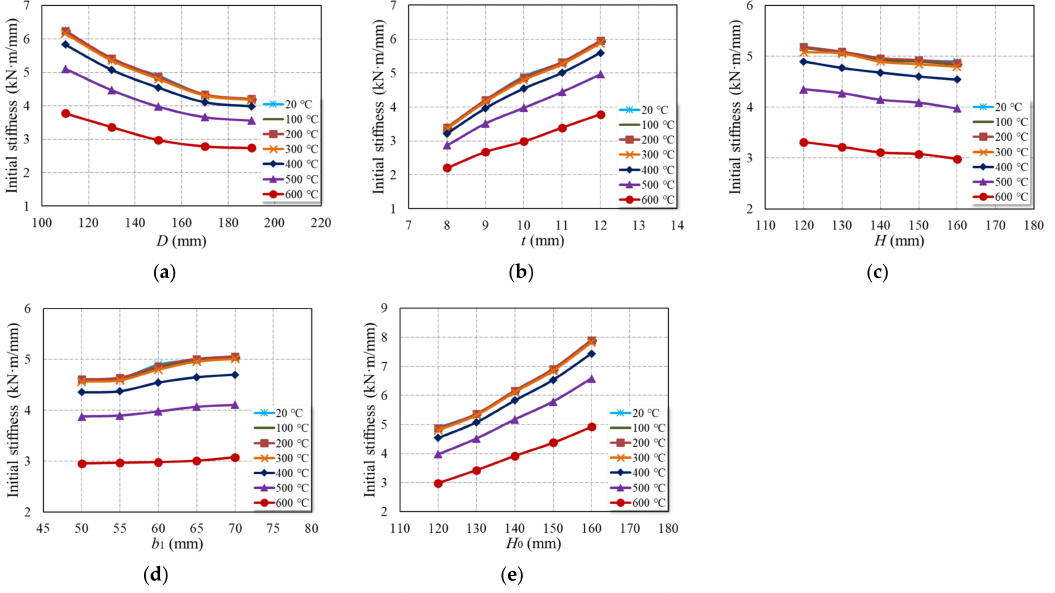
Figure 15. Effects of parameters on the initial stiffness of BBC joints under positive bending: ( a ) outer diameter of the tube; ( b ) thickness of the tube; ( c ) height of the tube; ( d ) width of the tubular beam; ( e ) height of the tubular beam.